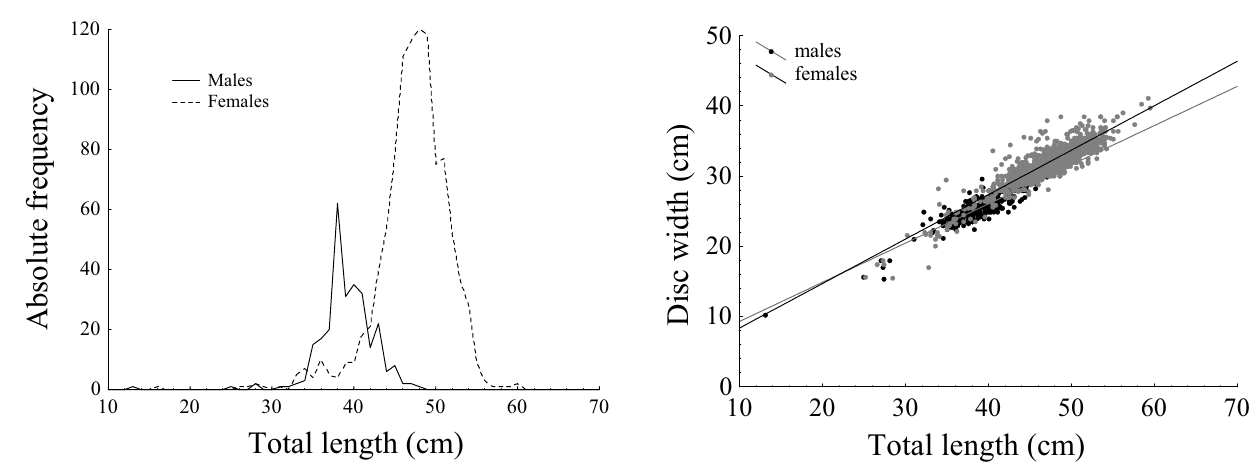
Fig. 4. Relationship of disc width (cm) as a dependent variable of total length (cm) for males (black symbols) and females (grey symbols) of Rioraja agassizi.